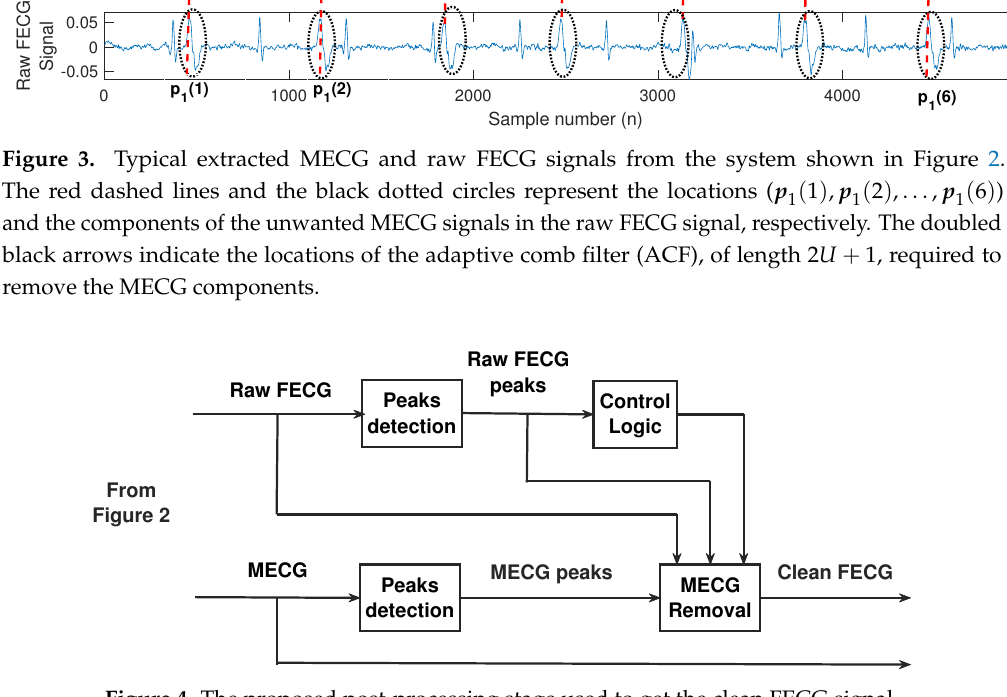
Figure 4. The proposed post-processing stage used to get the clean FECG signal.